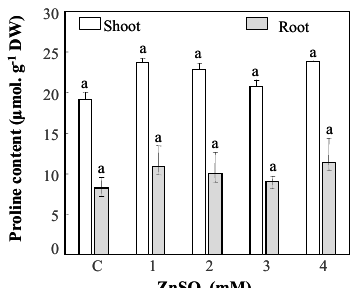
Fig. 6: Shoot and root proline content of fenugreek plants grown with dif- ferent ZnSO 4 concentrations for 52 days. Values (means ± SE of three replicates) followed by the same letter are not significantly dif - ferent (Duncan test, P = 0.05).